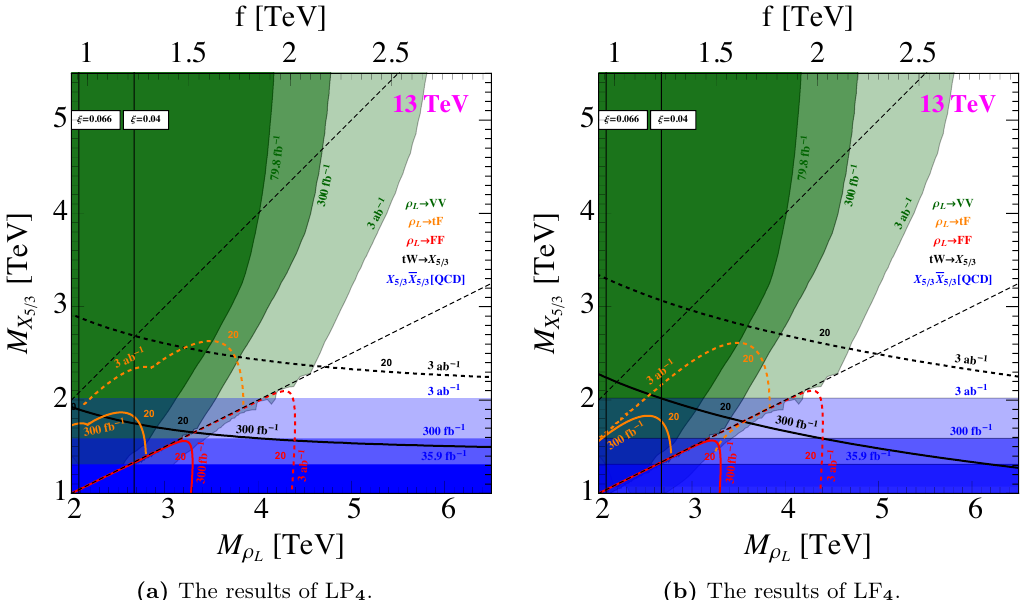
Figure 7. The current limits and prospective reaches on model LP 4 (left plot) and model LF 4 (right plot). The parameters are chosen as eq. (3.1). The existing limits are shown as the darkest shaded regions, while the projections for 300 (3000) fb (cid:0) 1 are plotted the lighter shaded regions. The production channels include Drell-Yan (cid:26) (cid:6) ; 0 ! W (cid:6) Z=W + W (cid:0) [11] (denoted as (cid:26) L ! V V ) L (cid:22) X and QCD pair production of X [13]. The event number contours for N ( ‘ (cid:6) ‘ (cid:6) + jets) = 20 5 = 3 5 = 3 are plotted in solid (dashed) lines for 300 (3000) fb (cid:0) 1 , to set a prospective limit for the proposed (cid:22) X (cid:22) X (cid:6) ; 0 (cid:22) t (denoted as (cid:26) channels, including (cid:26) (cid:6) ! t (cid:22) B=X ! X =X (denoted L ! tF ), (cid:26) 5 = 3 5 = 3 2 = 3 5 = 3 5 = 3 L L as (cid:26) L ! FF ) and tW ! X . See the main text for more 5 = 3